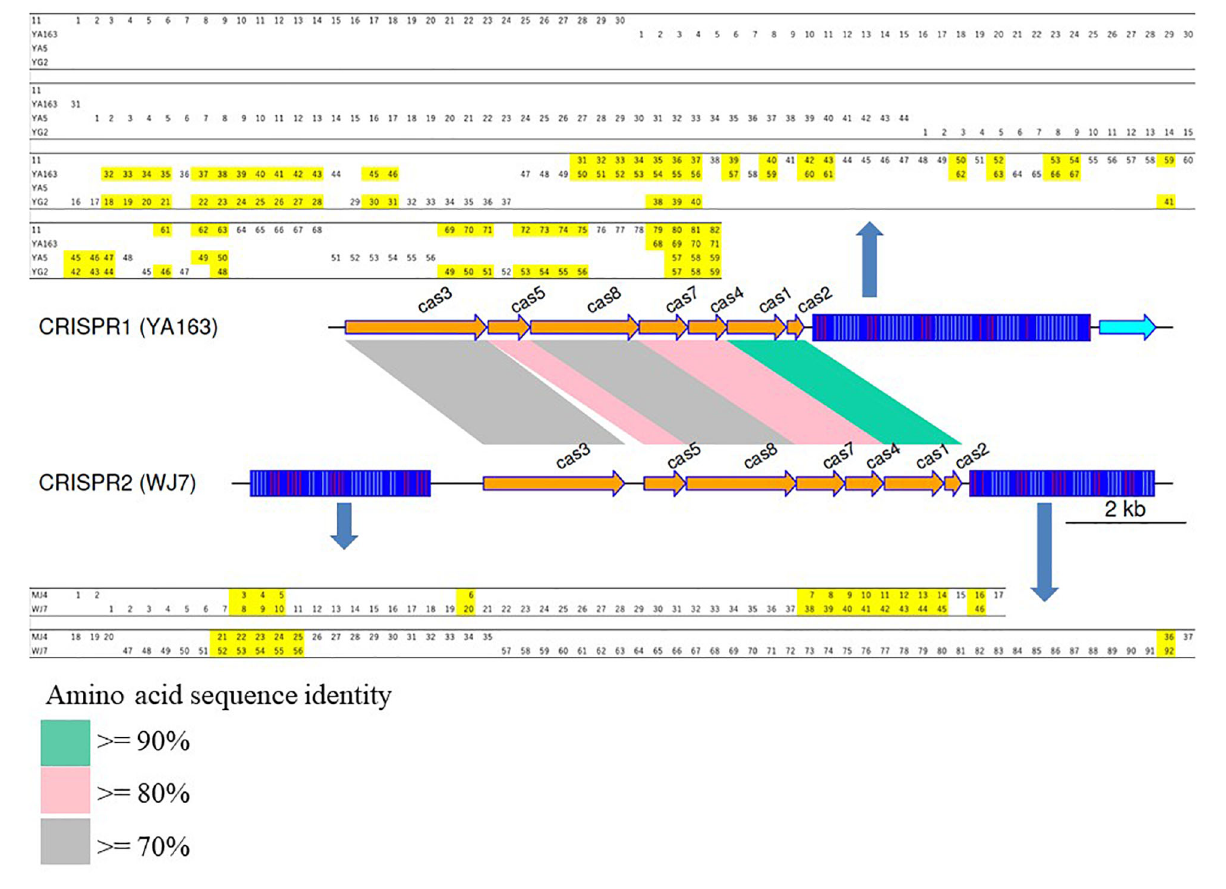
FIGURE 2 | Graphical representation of the CRISPR gene clusters for CRISPR1 (strain YA163) and CRISPR2 (strain WJ7). The figure was produced using genoPlotR 0.8.9 (Guy et al., 2010). Spacer sequences completely conserved in more than two strains are highlighted with yellow. Spacer numbers used in this figure are also listed in Supplementary Table 4